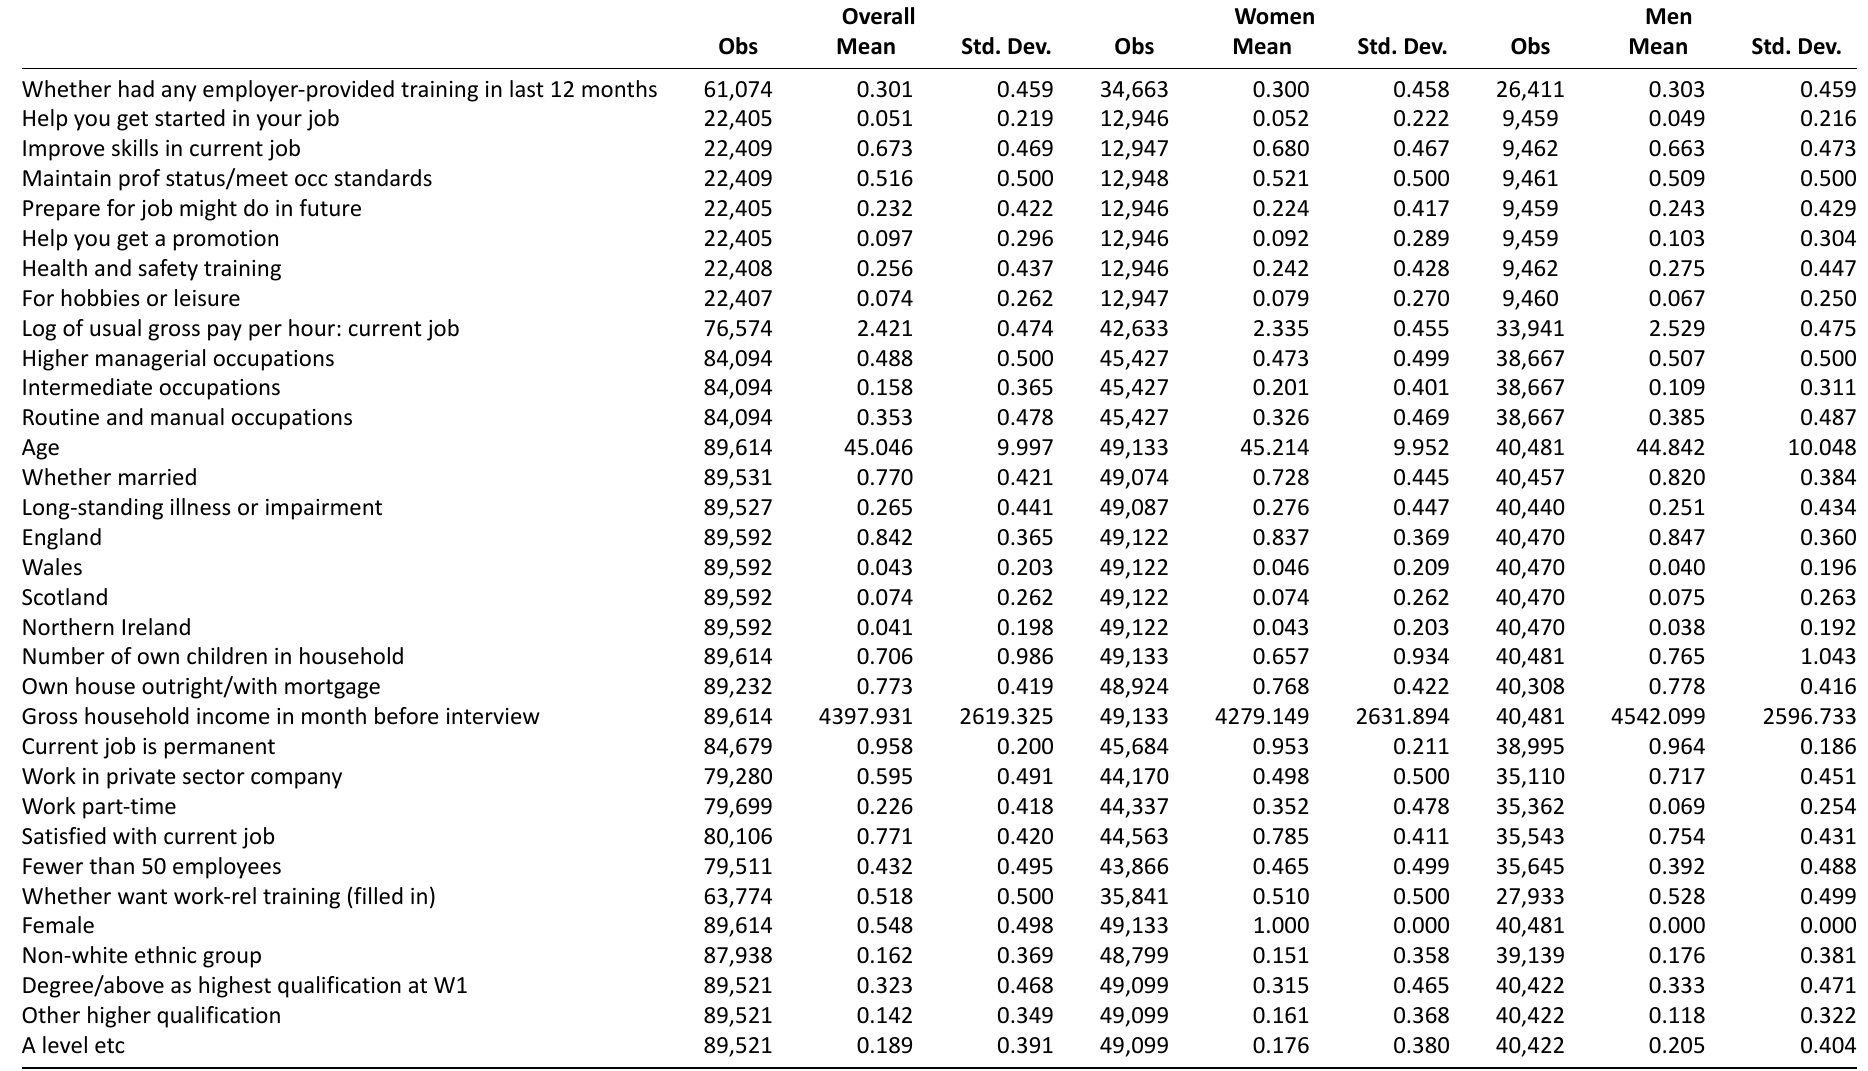
Table A2. UKHLS waves 1–7 summary